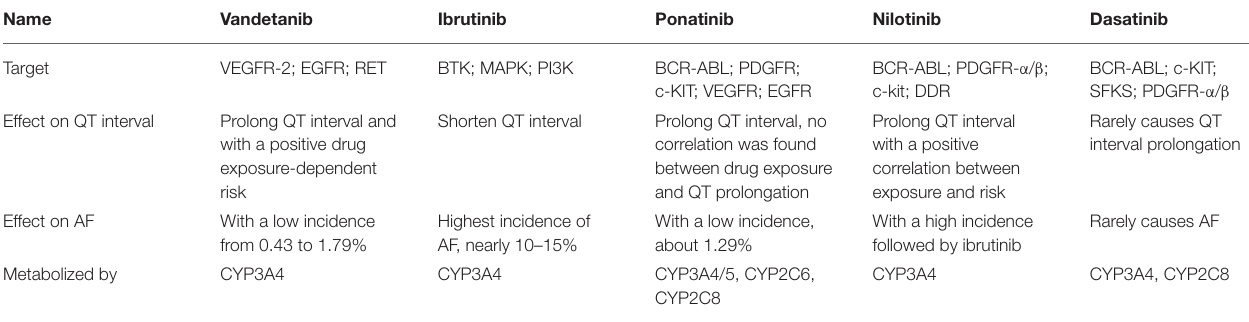
TABLE 1 | Target, effect on QT interval/AF, and metabolism of selected representative